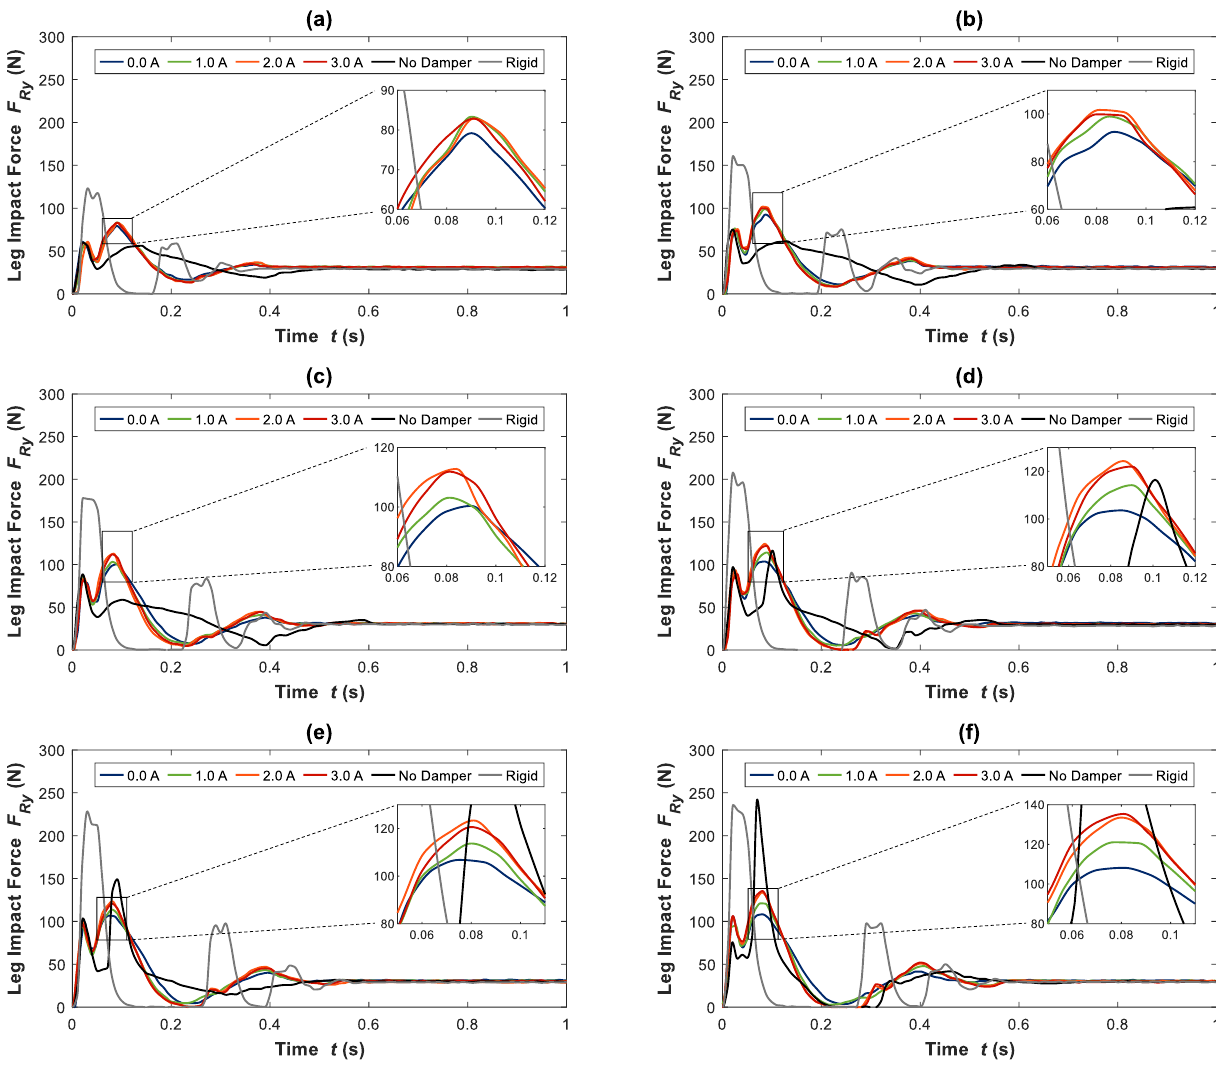
Figure 7. Leg impact force for impact tests with a 2.65 kg total mass for drop heights of ( a ) 100 mm,